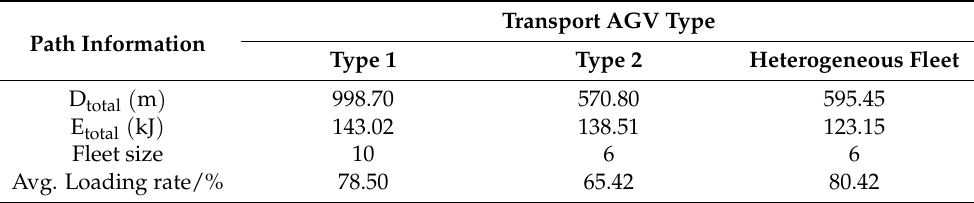
Table 13. Comparison of objective corresponding to the optimal paths under three conditions. Path